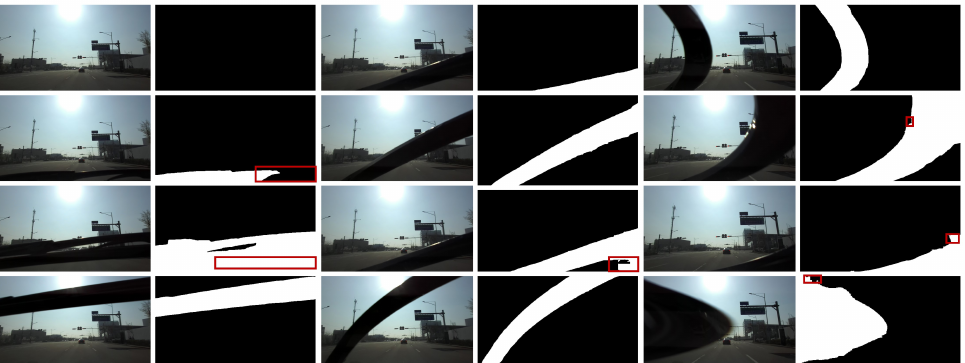
Figure 15. Wiper detection results in backlit situations under clear weather conditions: original wiper images and corresponding detected wiper masks (white area). Despite the solid backlit situation in clear weather conditions, our model accommodates adverse brightness conditions and shows plausible detection results. Best viewed with